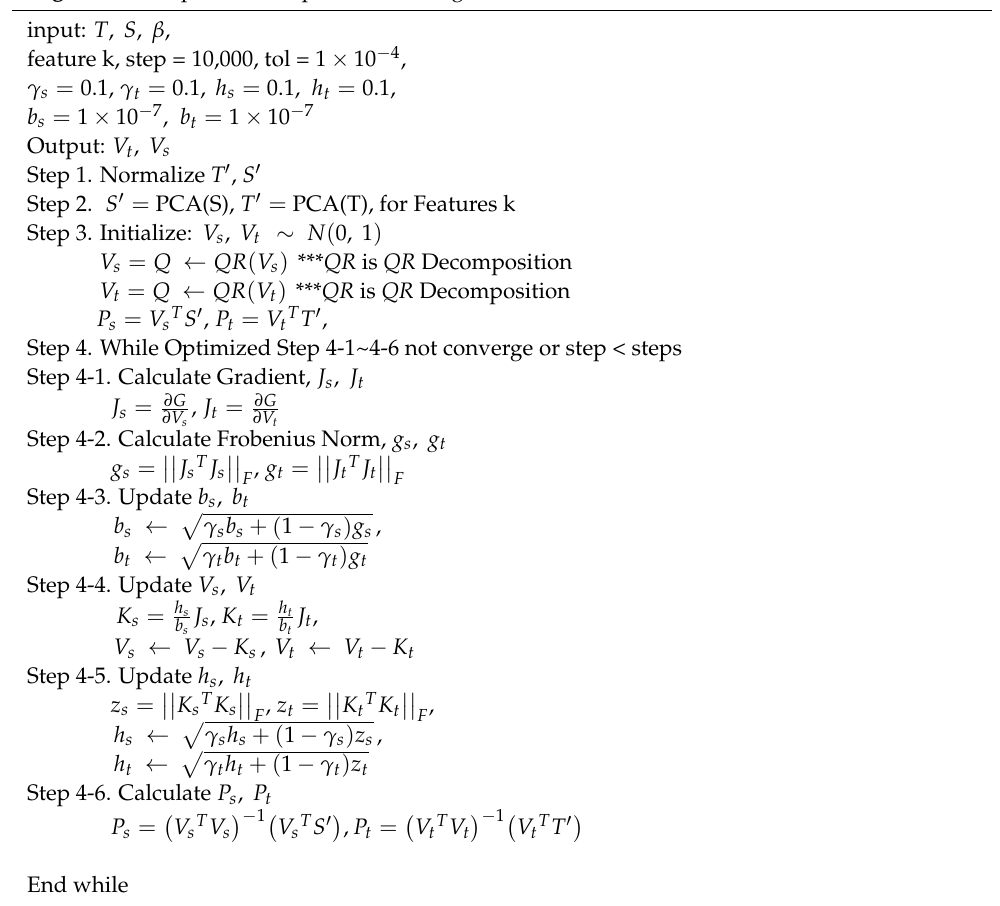
Algorithm 1: Optimization performance